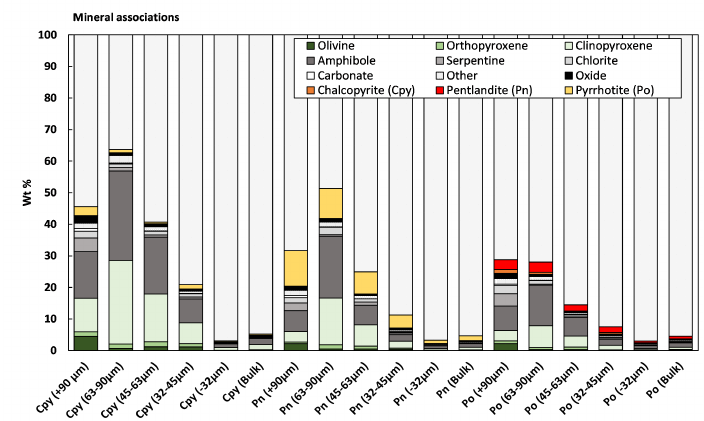
Figure 5. Mineral association in the